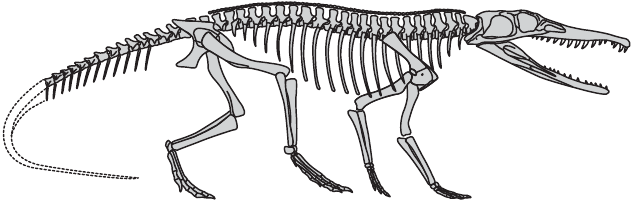
Fig. 3. Reconstruction of the skeleton of Chanaresuchus Romer, 1971 (modified from Mancuso et al. 2014).